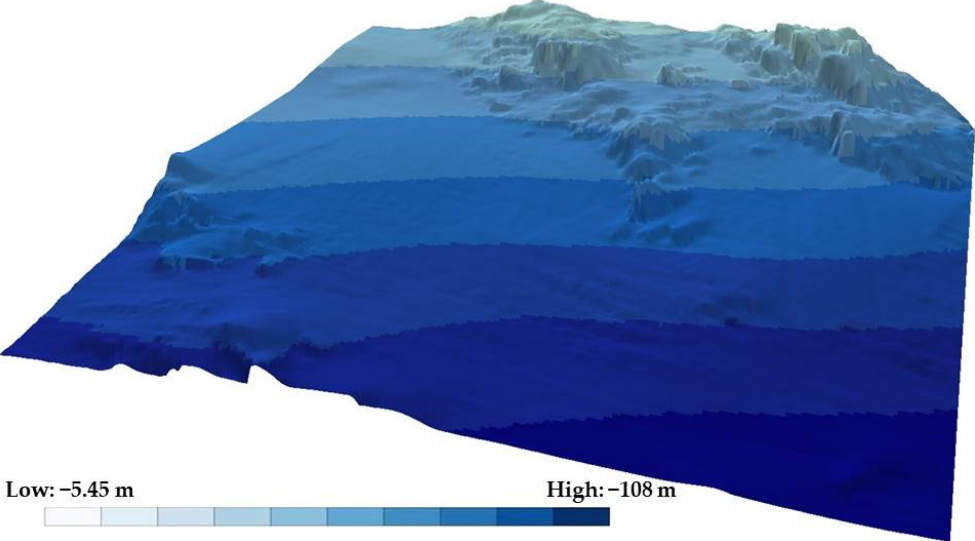
Figure 8. Three-dimensional representation of the seafloor in sector B. The detail permits us to appreciate the high variability of the seafloor.